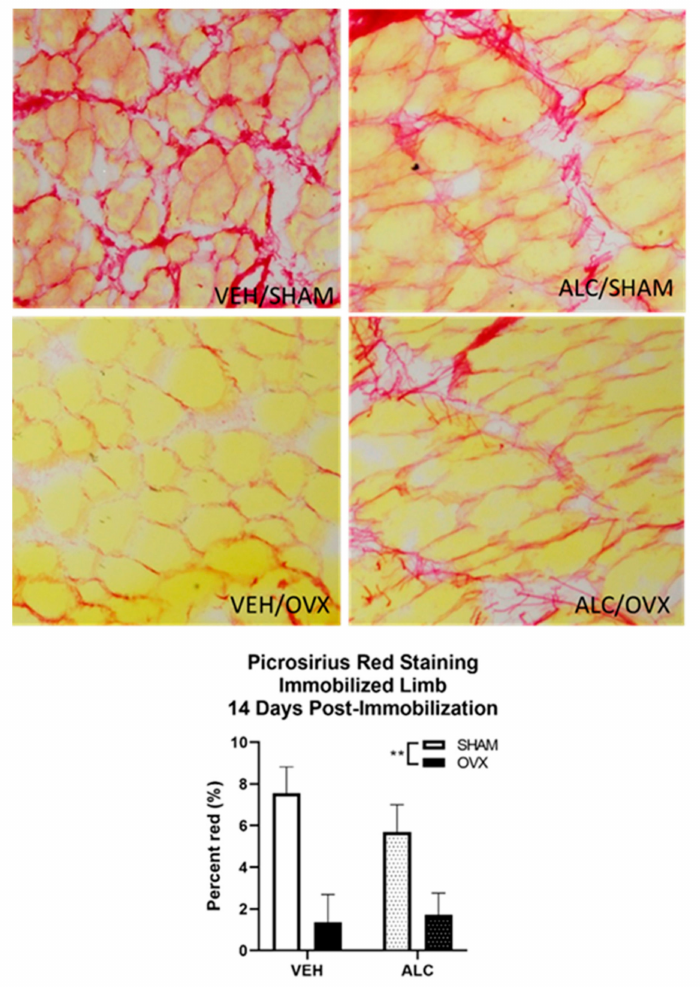
Figure 5. Picrosirius red staining of the quadriceps muscle of the immobilized hind limb after 14 days of post-immobilization recovery, with or without alcohol (ALC) and ovariectomy (OVX). Data analyzed by two-way ANOVA, ** p < 0.01, Mean ± SEM. Images obtained at 10x